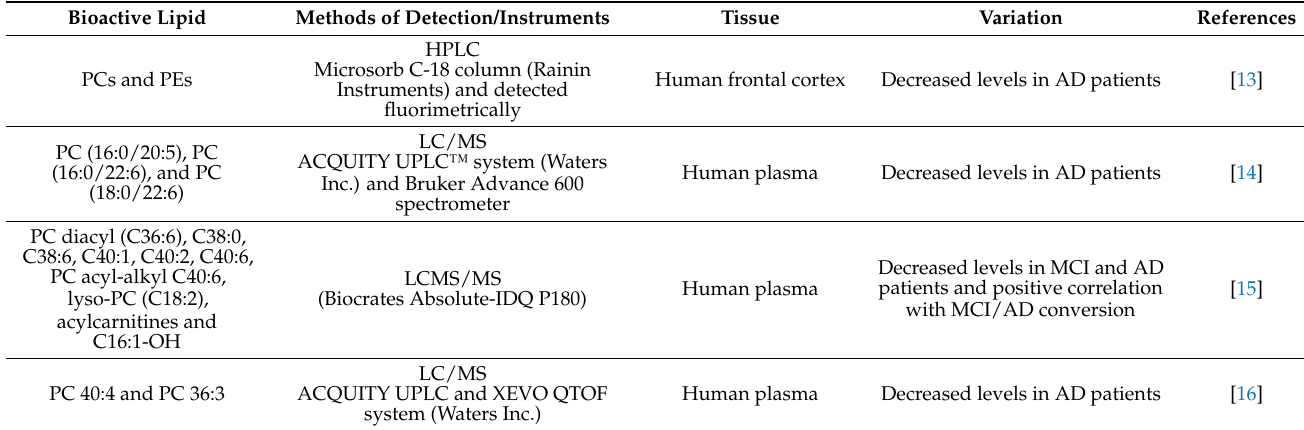
Table 1. Bioactive lipid evaluation in Alzheimer disease by